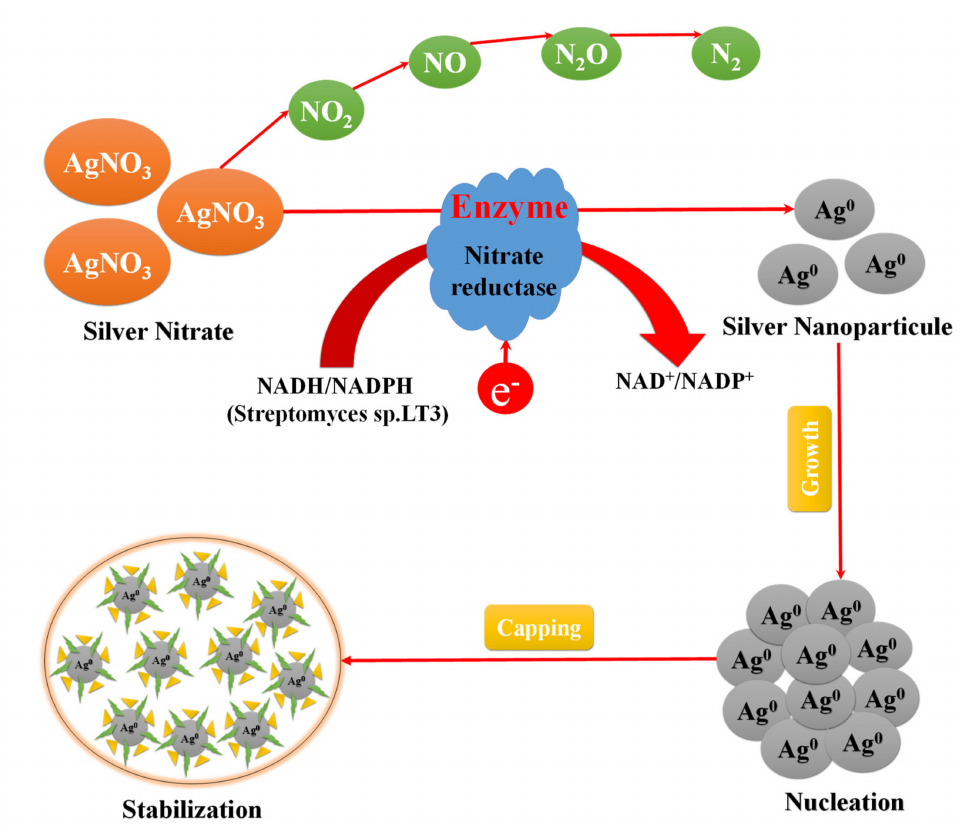
Figure 8. Proposed mechanism for Ag NPs synthesis by Streptomyces sp.LT3 involving NADH/NADPH dependent nitrate reductase enzyme, modified with permission from Ref. [106], Royal Society of Chemistry,